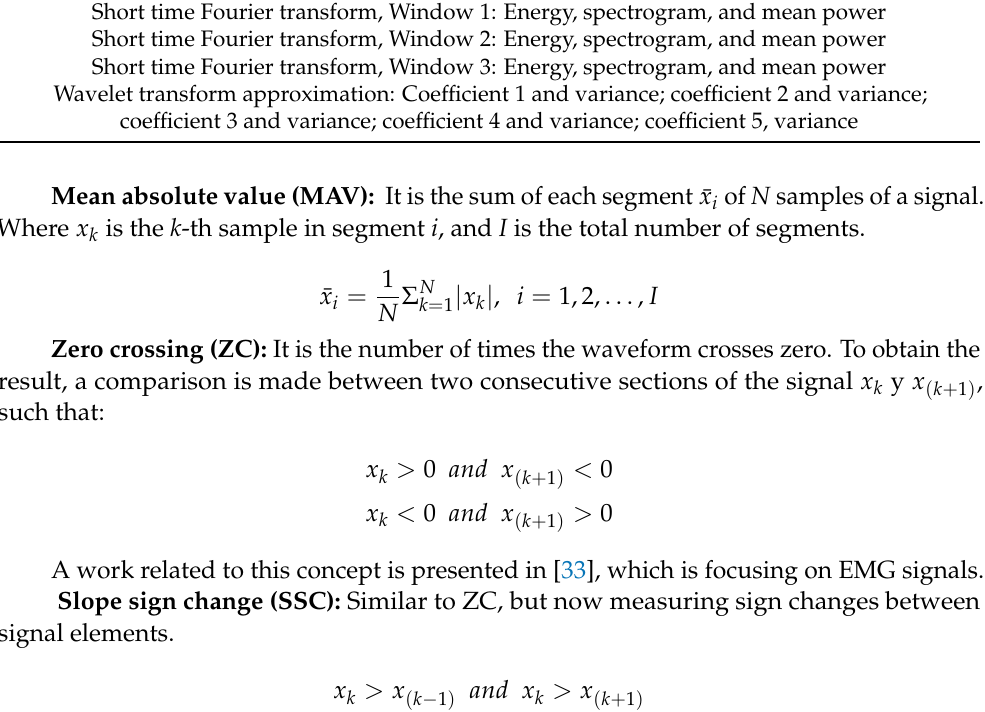
Slope sign change Waveform length Autoregressive model AR (5): first, second, and third coefficients Fast Fourier Transform: Energy, periodogram, and mean power Short time Fourier transform, Window 1: Energy, spectrogram, and mean power Short time Fourier transform, Window 2: Energy, spectrogram, and mean power Short time Fourier transform, Window 3: Energy, spectrogram, and mean power Wavelet transform approximation: Coefficient 1 and variance; coefficient 2 and variance; coefficient 3 and variance; coefficient 4 and variance; coefficient 5,